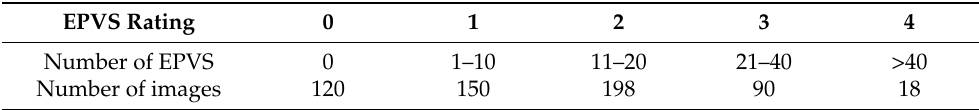
Table 2. Rating score of EPVS and manual ratings of the dataset (576 images in total) in basal ganglia